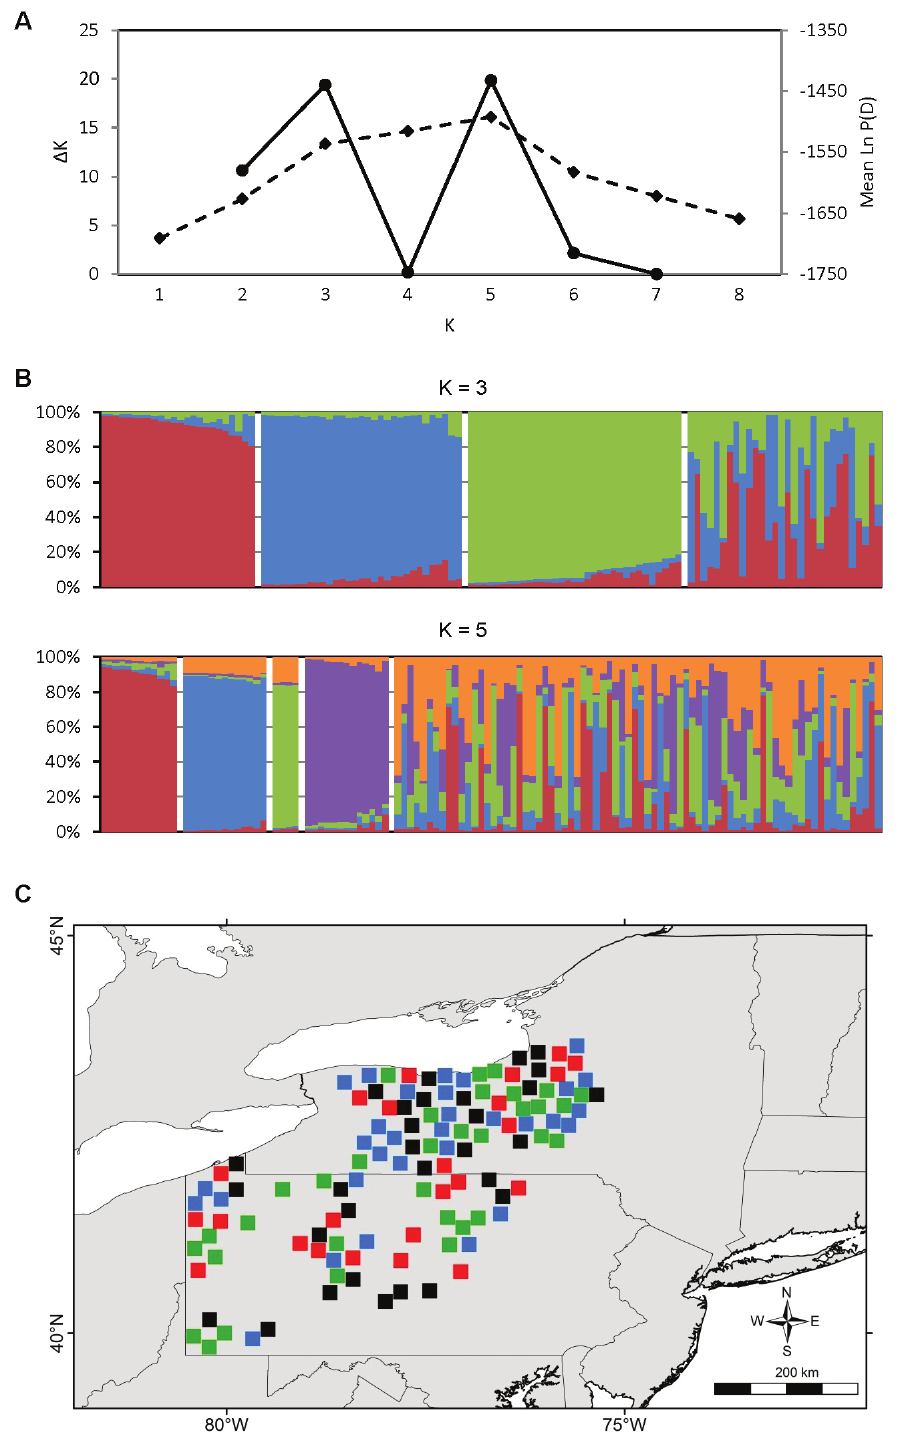
Figure 4. Population genetic structure of eastern coyotes in the contact zone. A ) Estimation of the number of genetic populations using two criteria: Δ K (solid line) and Ln P(D) (dashed line). The data strongly support K = 3 and K = 5. B ) STRUCTURE bar plots of N = 118 coyotes subdivided into K = 3 and K = 5 genetic clusters. C ) Spatial distribution of K = 3 genetic clusters. Symbol colors represent the genetic cluster with > 80% assignment from panel B , or black if highly admixed ( i.e. , no assignment >